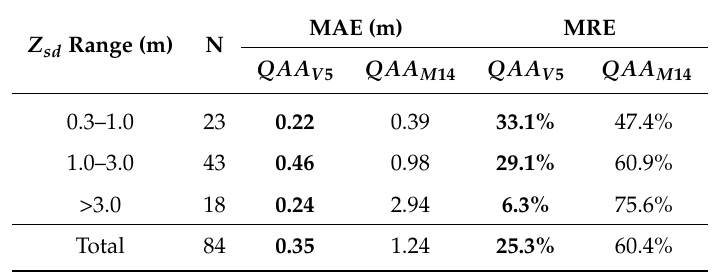
Figure 4. Estimated AHSI image Z sd for 84 match-up in situ measurements using the semi-analytical method: ( a ) QAA V 5 , and ( b ) QAA M 14 . Table 4. Mean absolute errors (MAEs) and mean relative errors (MREs) of the estimated Advanced HyperSpectral Imager (AHSI) image Z sd based on semi-analytical methods using various Quasi-Analytical Algorithm (QAA) algorithms. Optimal results listed in bold.